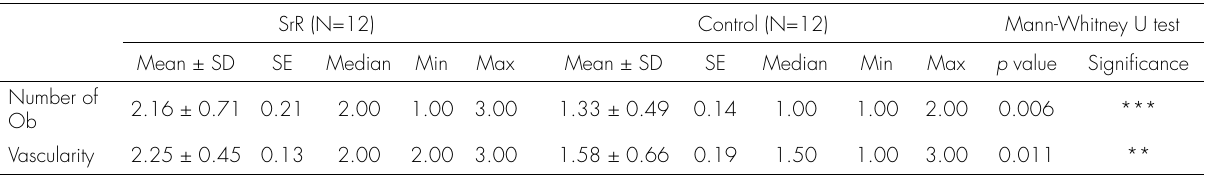
SrR: Strontium ranelate; Ob: Osteoblast; Min: Minimum; Max: Maximum; SD: Standard deviation; SE: Standard error; **: p < 0.01; ***: p < 0.001